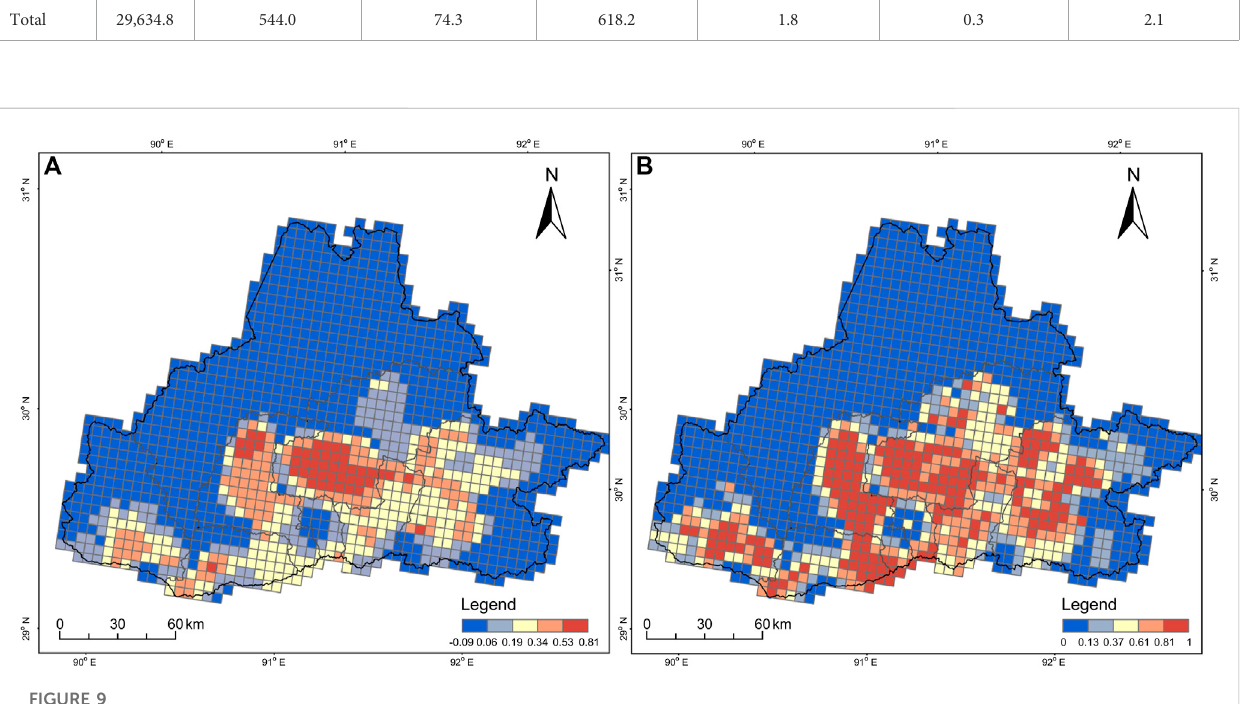
FIGURE 9 Correlation analysis of cultivated land and WRSIA by GWR. (A) Regression coef fi cient; (B) correlation coef fi